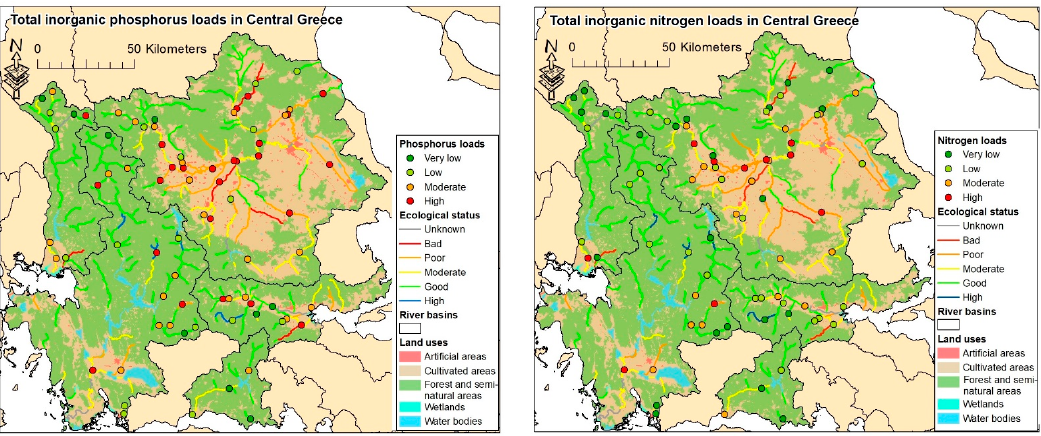
Figure 3. Maps are showing ecological classification of water bodies and classes of phosphorus loads ( left ) and total inorganic loads ( right ) in catchments of Central Greece.